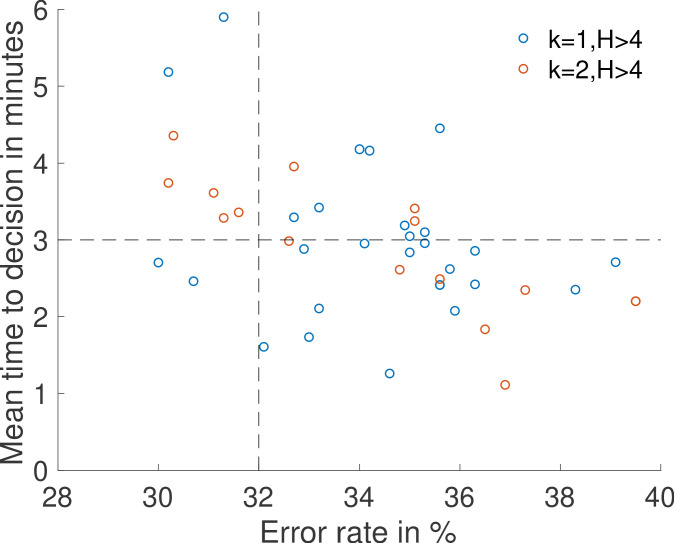
Results of a search for sets of parameters rON, rOFF, rb, dON, dOFF, c1 and c2 that lead to an accurate decision (e<32%) in a short time (⟨T⟩<180s).The ON and OFF times are drawn from the fastest architectures identified with rules k=1, H>4 (blue dots) and k=2, H>4 (red dots). Concentrations are L1=1.05⁢L0 and L2=0.95⁢L0.